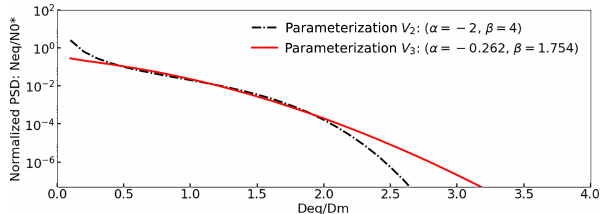
Figure 2. Lookup table parameters: the normalized PSD (DARDAR-CLOUD V 2 is represented by the black dashed line, and the new parameterization, V 3 , is represented by the red solid line).